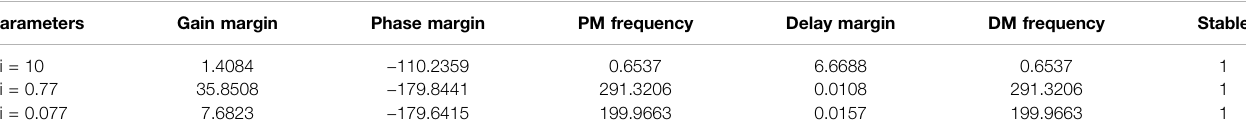
TABLE 2 | The frequency domain analysis parameters for different K ii values.